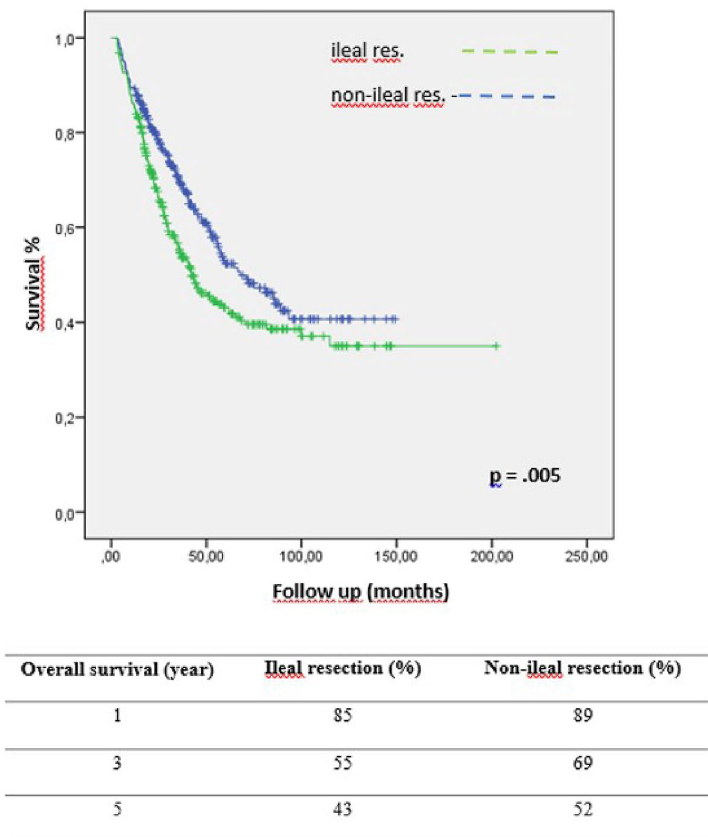
Table 4. Overall survival of the patients between two groups.